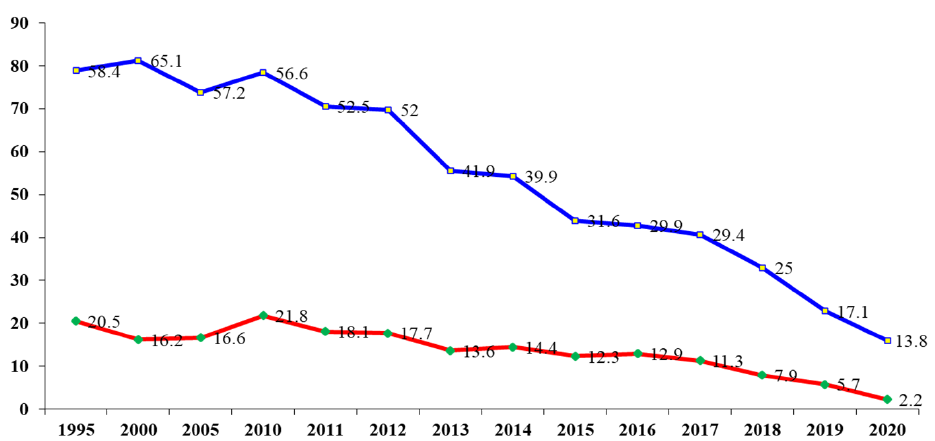
Figure 1. Incidence (red line) and prevalence (blue line) of tuberculosis per 100,000 children aged 0–17 in Bulgaria for 2000–2020 inclusive.